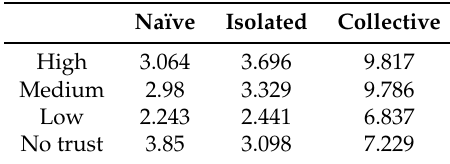
Table 4. Service time with 70% malicious.